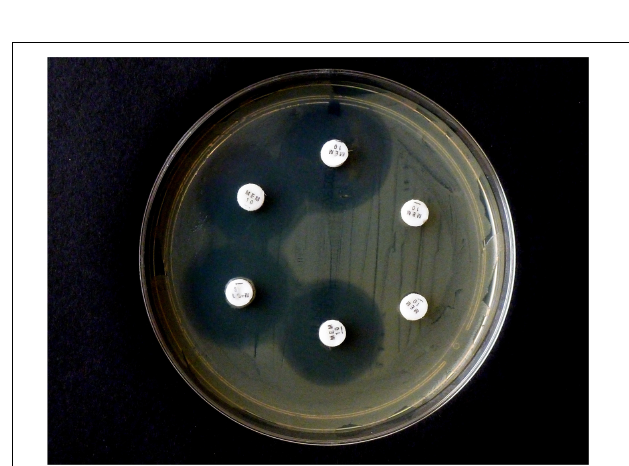
FIGURE 3 | Results from carbapenem inactivation method CIM with meropenem. Tested isolates were (in clockwise sequence): E. coli ATCC 25922 (top), E. coli OXA-48 (No. 16), E. kobeii AmpC (No. 79), and K. aerogenes AmpC (Nos. 60, 61, 62). The MEM disks were kept in an aqueous bacterial suspension for 6 h at 35 ◦ C. Indicator strain was E. coli ATCC